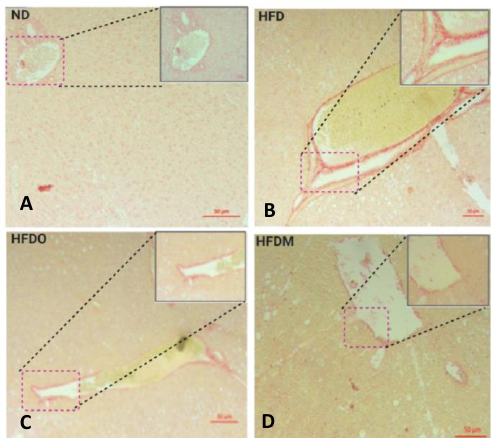
Figure 12. Effect of a high-fat diet (HFD) on hepatic fibrosis. High-fat diet treatment increased collagen deposition in the liver, indicated by a higher intensity of Sirius red staining. This fibrosis was prevented in animals treated with MESK (Magnification 10x). ( A ) Normal diet, ( B ) high-fat diet, ( C ) HFDO: HFD + Orlistat, and ( D ) HFDM: HFD +MESK. Scale bar indicates 50 µm.